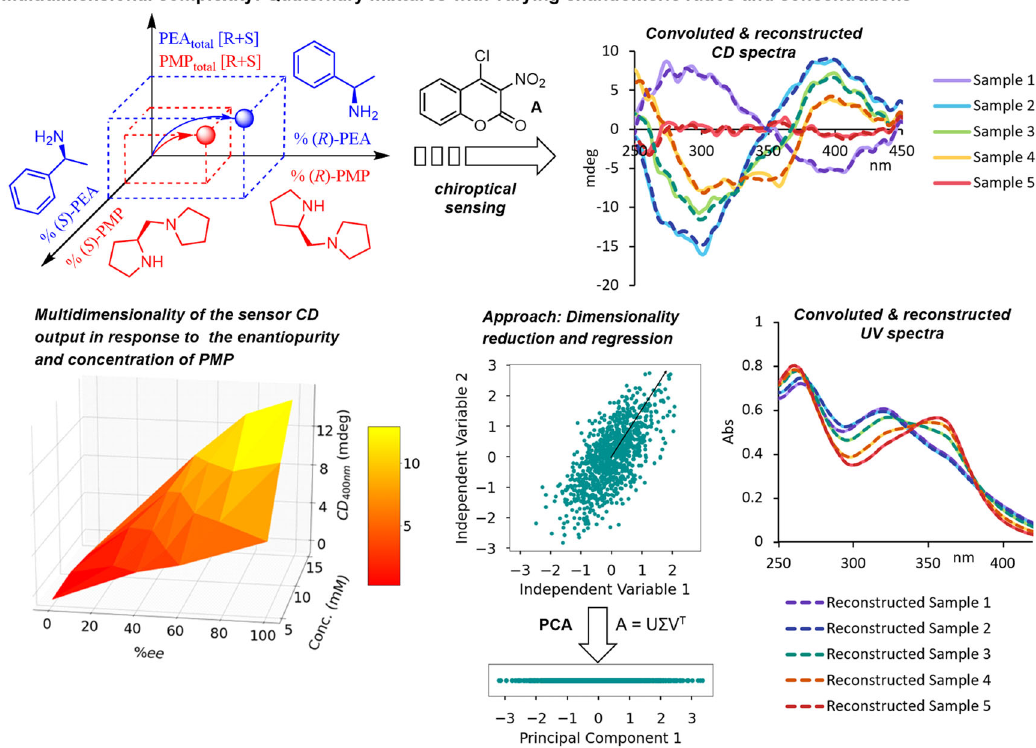
Fig. 3 Multidimensional complexity of quaternary mixtures of the individual enantiomers of PEA and PMP in varying concentration and enantiomeric composition. The dependence of the induced CD signal on the sample concentration and enantiopurity is shown exemplarily for PMP in a 3D plot. The convoluted UV and CD spectra of fi ve samples and the reconstituted spectra were subjected to PCA (principal component analysis); A is the m × n matrix. U is the Eigenvector of A T A. V T is the Eigenvector of AA T . Σ contains the square roots of the Eigenvalues. PEA : 1-phenylethylamine, PMP : 1-(pyrrolidin-2- ylmethyl)pyrrolidine. The data underlying this fi gure are available as Source higher signal-to-noise ratio. This is exempli fi ed by the training set #13 containing equimolar amounts of both enantiomers of PEA and PMP at 5.50 and 4.50 mM, respectively. The absolute errors were determined as 1.65 mM for ( R )- PEA , 1.13 mM for ( S )- PEA , 0.51 mM for ( R )- PMP , and 1.04 mM for ( S )- PMP as indicated by the light green to yellow colors in the heat map. This contrasts with the training set #16 containing enantiopure ( R )- PEA and ( R )- PMP at 7.00 and 13.00 mM, respectively, and thus producing relatively strong ICD signals upon reaction with the coumarin probe. In this case, the absolute errors are only 0.08 mM for ( R )- PEA , 0.29 mM for ( S )- PEA , 0.28 mM for ( R )- PMP and 0.00 mM for ( S )- PMP .